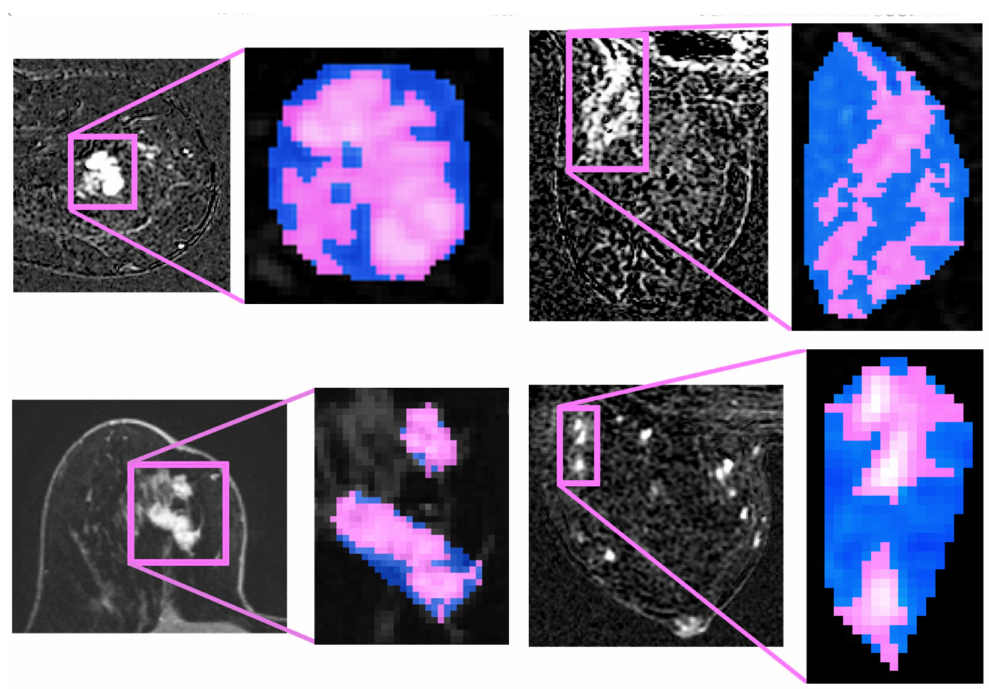
Figure 4. Four pre-processing examples. Left side halves: Bifocal lesion localized at upper-external quadrant, characterized by spiculated margins and IS/T curve. Right side halves: in pink, we highlight the original segmentation and, in blue, the convex hulls